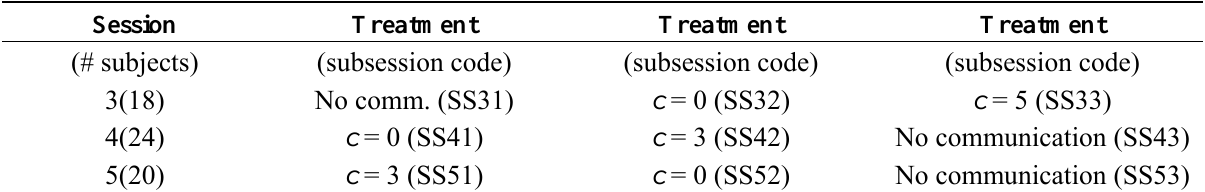
Table 1. Treatment